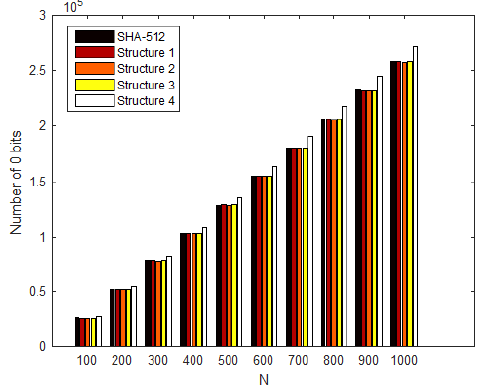
Figure 10. linear complexity of hash for 1000 different messages.